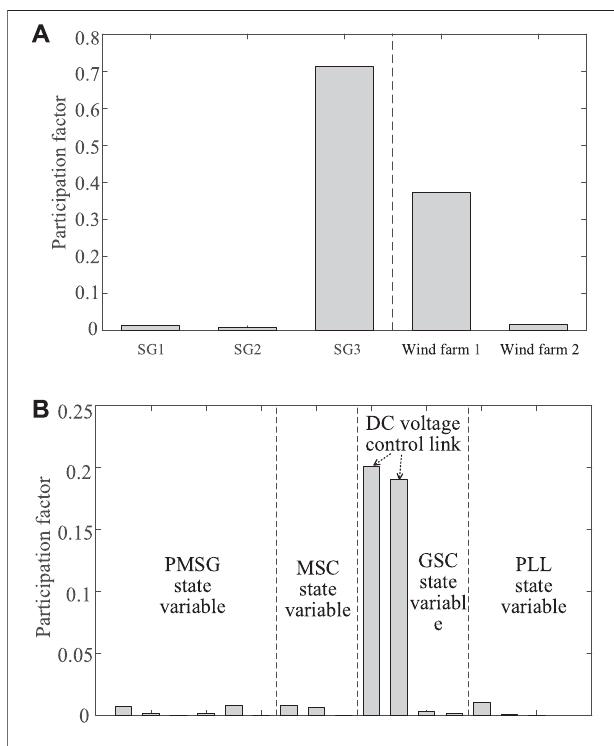
FIGURE 5 | Participation factors of λ 1 : (A) participation factors of three SGs and two wind farms to λ 1 and (B) participation factors of PMSGs in wind farm one to λ 1